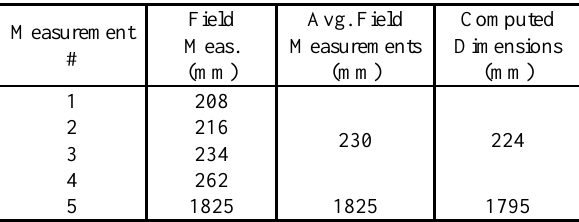
Table 2: The comparison between the field measurements and the computed surface damage